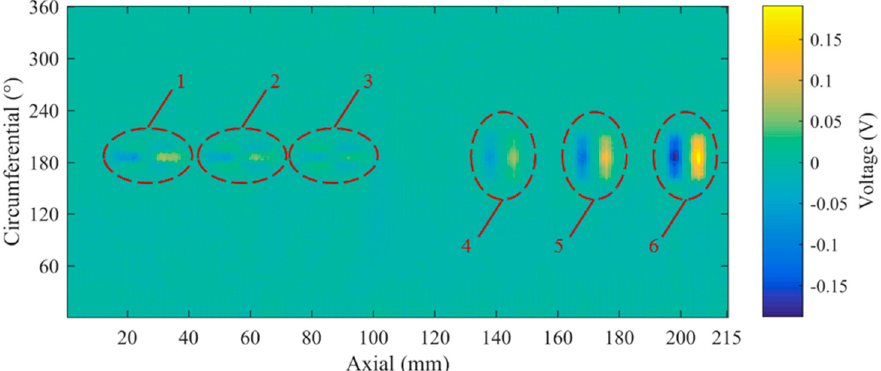
Figure 10. Inspection result of the specimen. 1—2.0 mm, longitudinal defect; 2—1.0 mm, longitudinal defect; 3—0.5 mm, longitudinal defect; 4—0.5 mm, transverse defect; 5—1.0 mm, transverse defect; 6—2.0 mm, transverse defect.